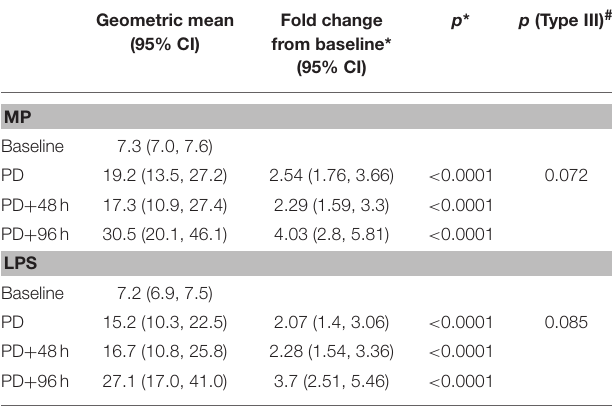
TABLE 3 | Analysis of ALS responses to MPN and LPS in participants challenged with Salmonella Paratyphi A and diagnosed with paratyphoid infection. Geometric mean (95%